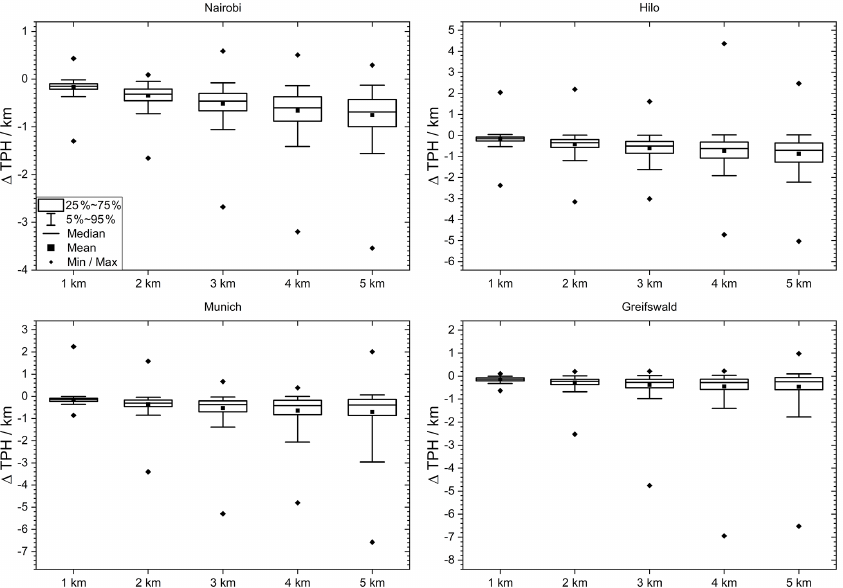
Figure 7. The cold point tropopause displacements for four geolocations as a function of the vertical resolution for Gaussian kernels. For details, see Fig. 3.